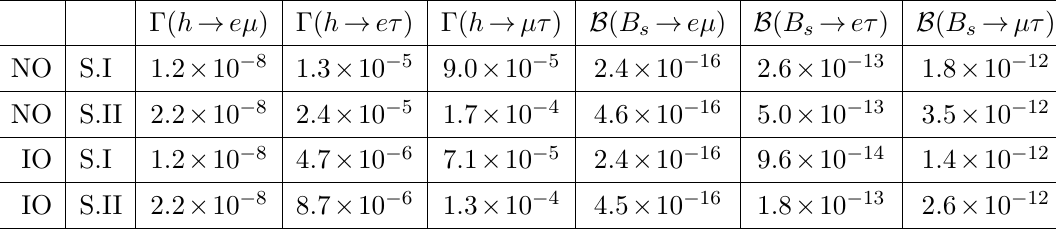
Table 3 . Upper bounds on (cid:0)( h ! ‘ i ‘ j ) [MeV] and B ( B s ! ‘ i ‘ j ) at